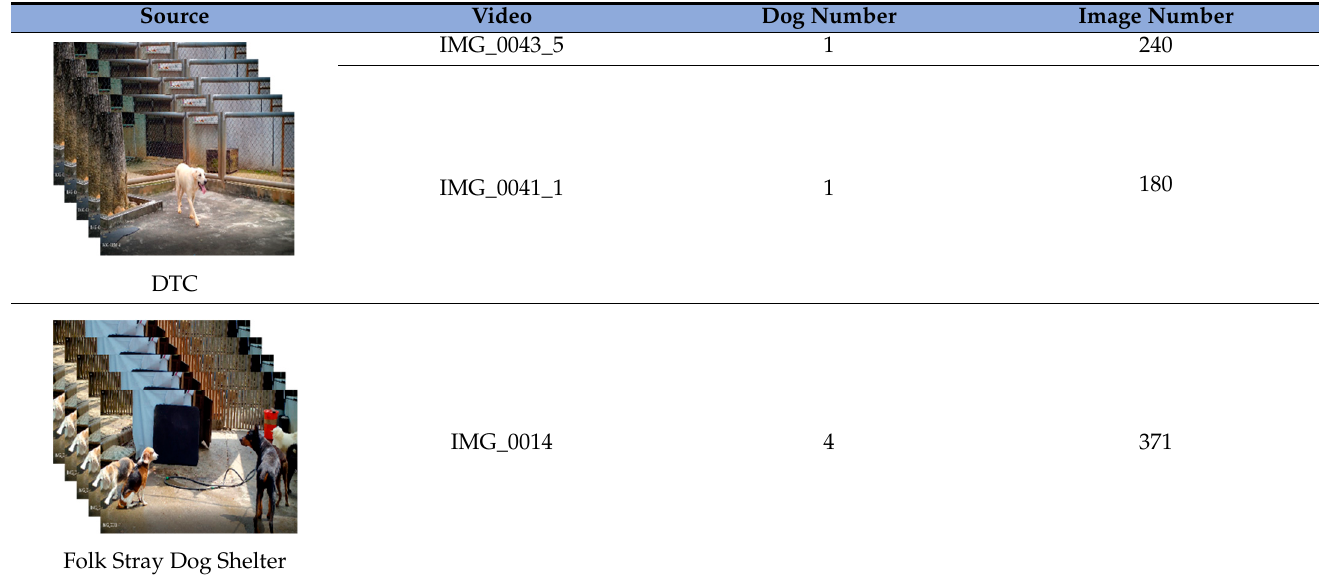
Table 5. Test videos used in dog-tracking